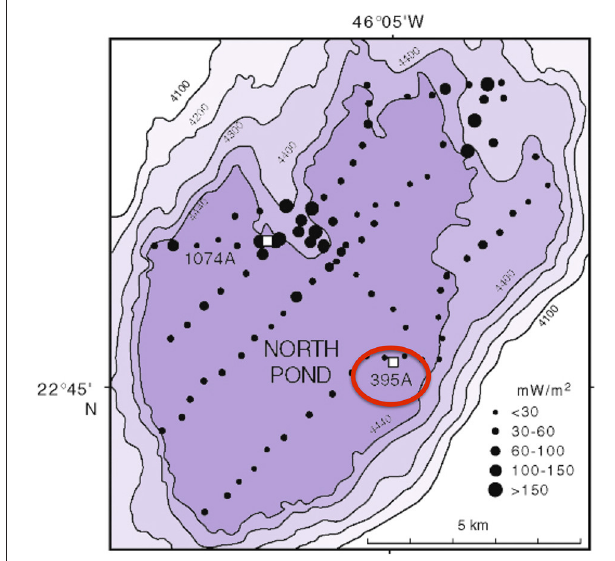
FIGURE 1 | Bathymetric map of North Pond showing the location of Hole 395A. The black circles represent a heat flow survey conducted during DSDP 78B (Langseth et al., 1992). Hole 395A was drilled during DSDP 45, and is located about 1 Km from the southeastern edge of North Pond (red circle).